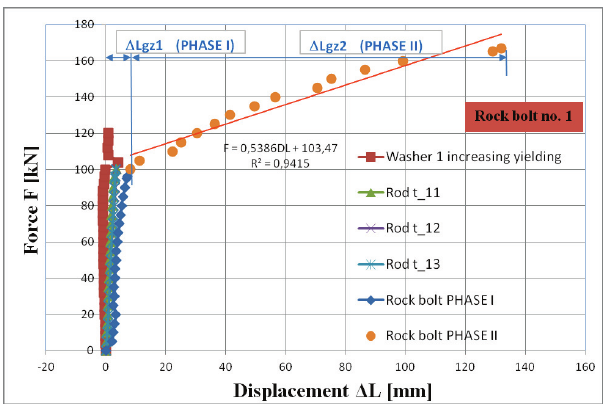
Fig. 16. The full loading characteristics for the rock bolt No. 1 with the deformable component